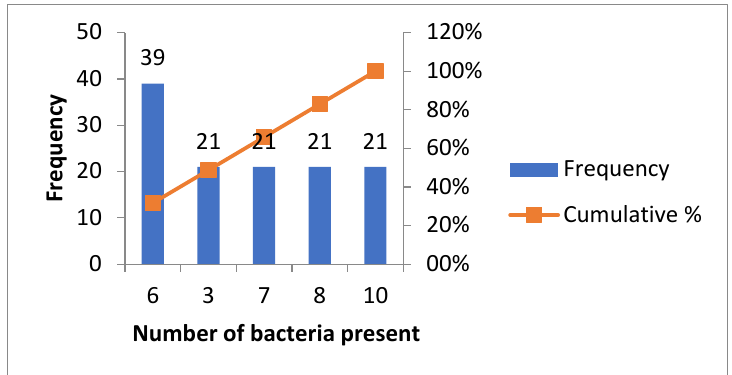
Figure 3. Graphical presentation with the histogram technique, of the number of patients in whom 3 or more bacteria were detected. Table 3. Descriptive presentation of the presence of bacteria in the three research